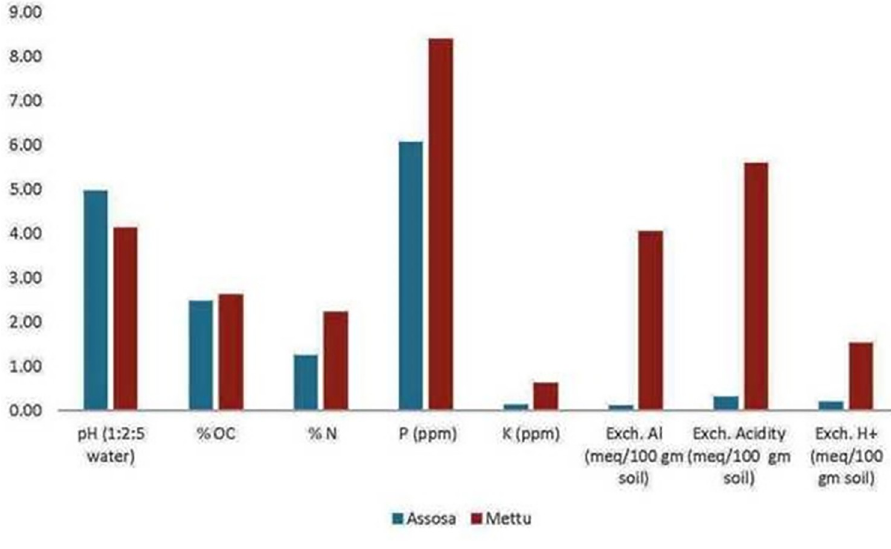
Fig 1. The different characteristics of the soil types of each of the test locations where the experiments were conducted.